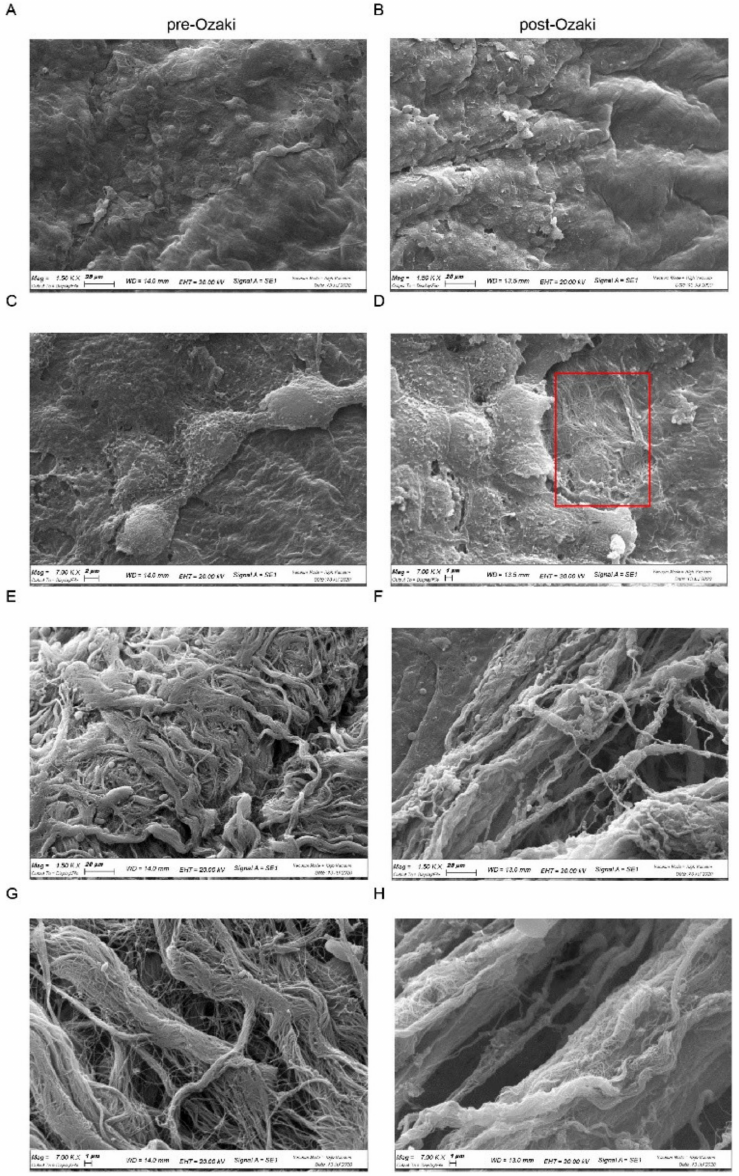
Figure 2. SEM morphological analysis of pre-Ozaki and post-Ozaki samples. ( A , C ) Representative images of the serosa layer in the pre-Ozaki pericardium show a continuous layer of mesothelial cells, whose surface is covered by short and abundant microvilli. ( B , D ) This layer appears interrupted in some areas (red box) in the post-Ozaki pericardium. ( E , G ) Representative images of the surface of the fibrosa layer in the pre-Ozaki pericardium display overlapping wavy collagen and elastic fibers. ( F , H ) These fibers assume a more parallel and compact arrangement in the post-Ozaki pericardium. Representative images at 1500 × ( A , B , E , F ) and 7000 × ( C , D , G , H )